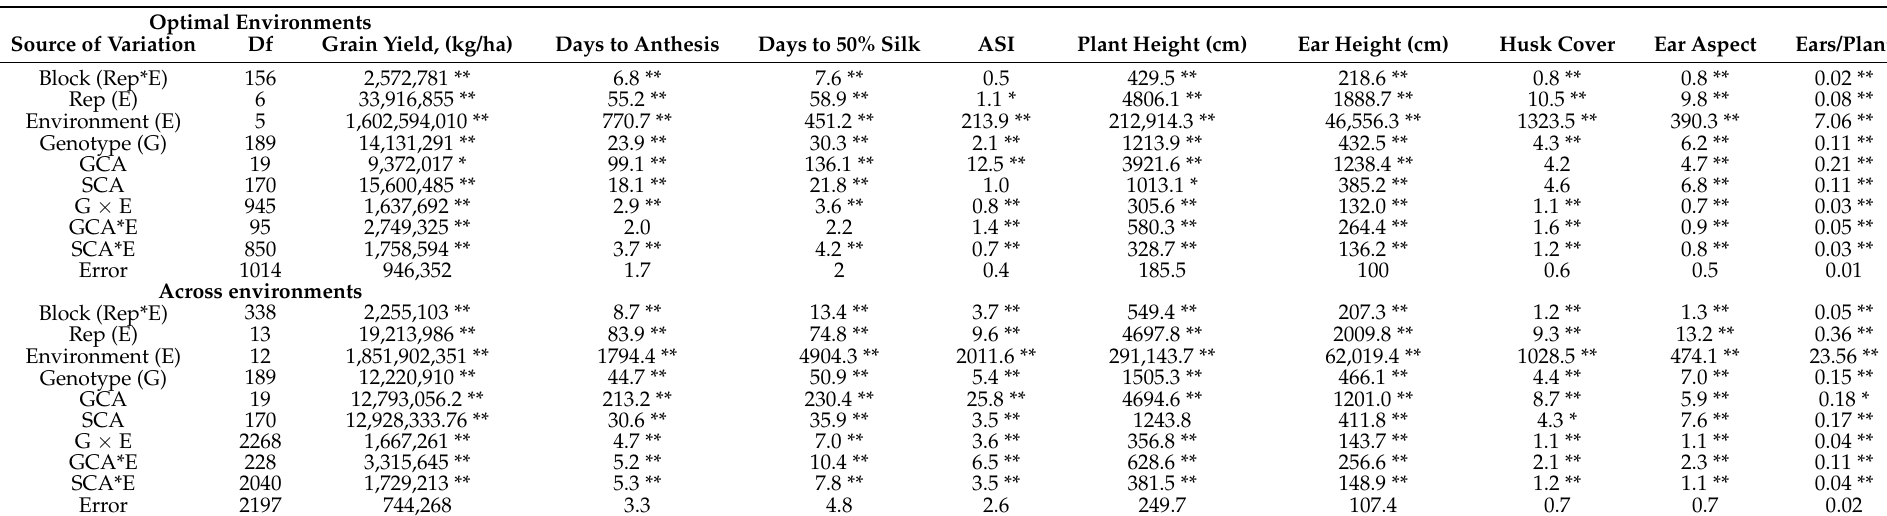
Table 3. Mean squares from the ANOVA of grain yield and other agronomic traits of 190 early maturing pro-vitamin A hybrids and 6 hybrid checks evaluated under optimal conditions and across stress and non-stress conditions in 2016 and 2017 in